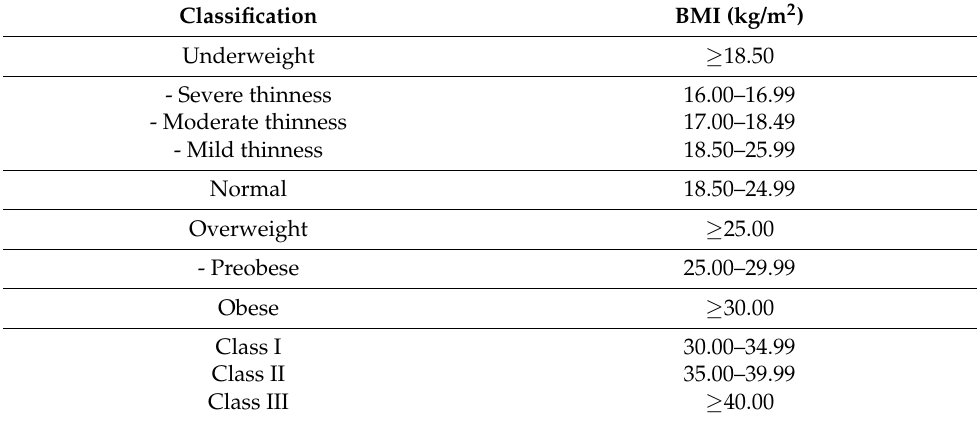
Table 2. International Classification of adults based on Body Mass